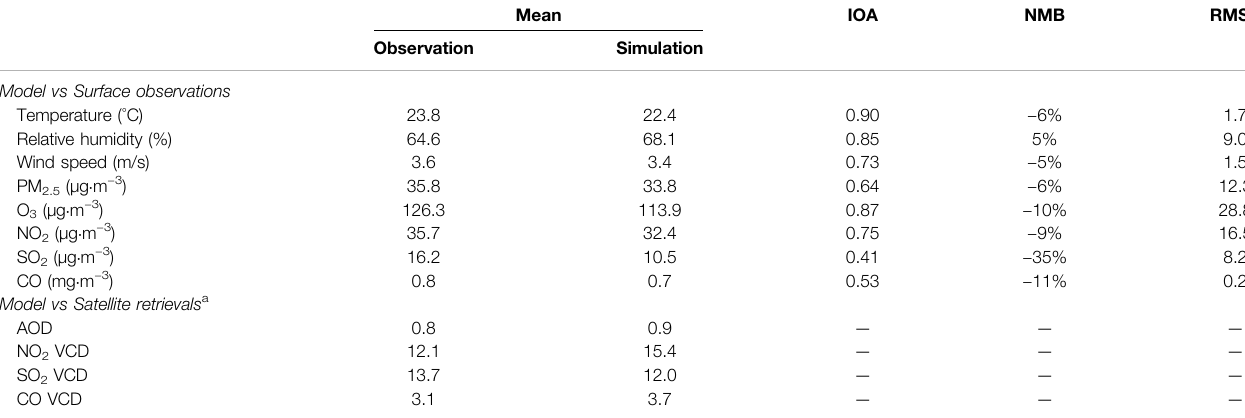
TABLE 2 | The comparison between simulations against surface observations or satellite retrievals. Mean IOA NMB RMSE